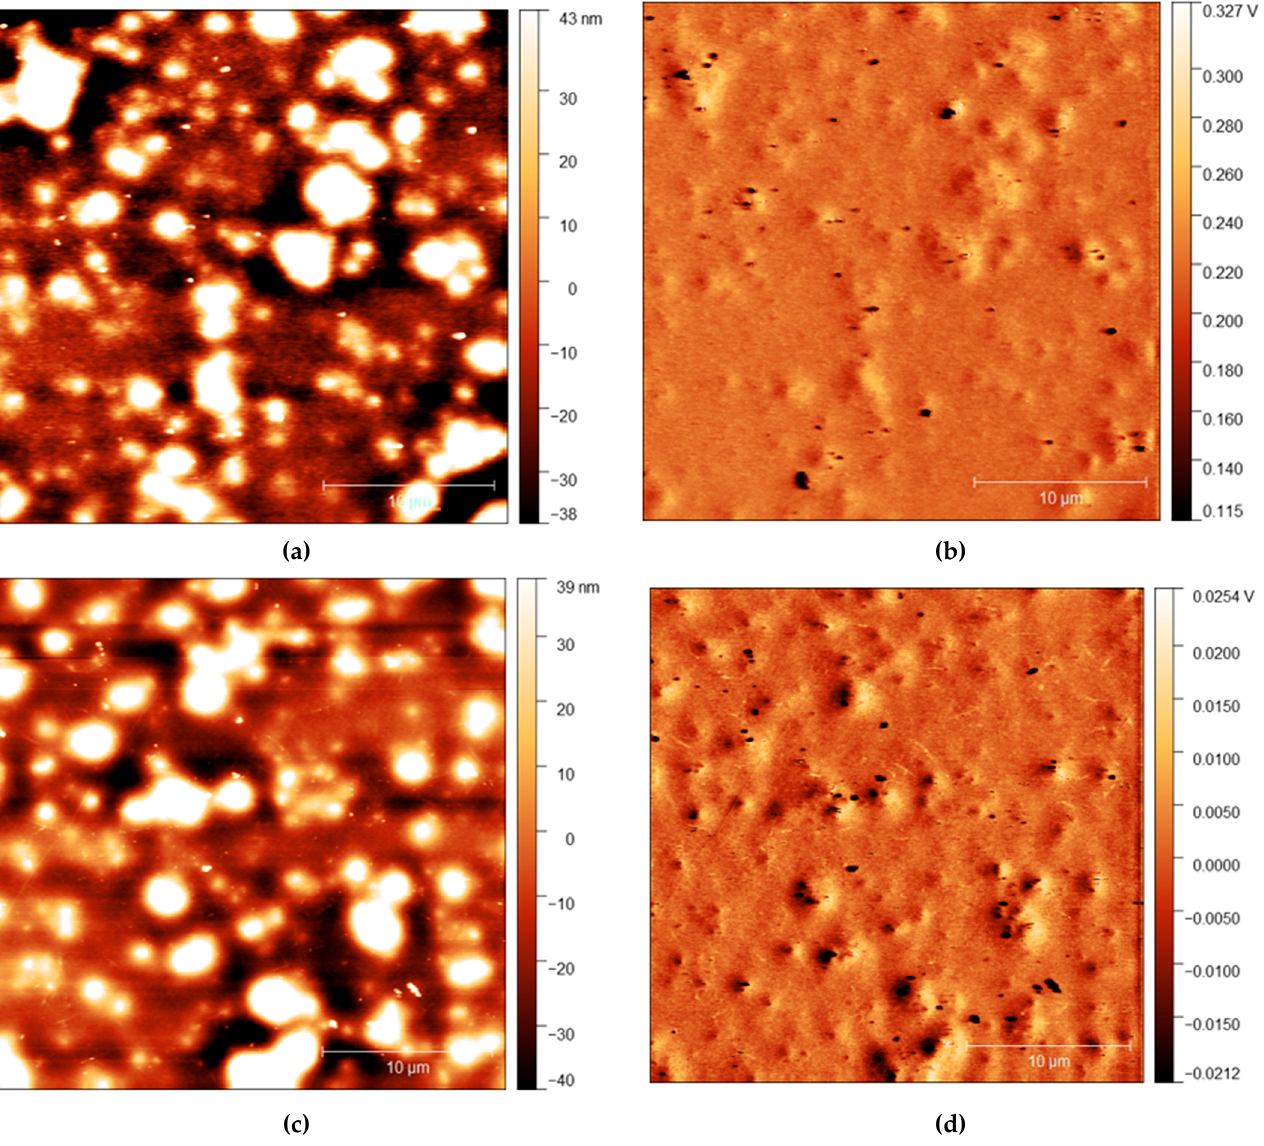
Figure 4. ( a ) AFM height map of cis -PI films with 0% loading of C 12 E 5 and ( b ) Adhesion maps for the same position on the Figure 4. (a) AFM height map of cis -PI films with 0% loading of C 12 E 5 and (b) Adhesion maps for the same position on the same film; ( c ) height map of the same film shown in the top AFM images after 10 s rinse and ( d ) the adhesion same film; (c) height map of the same film shown in the top AFM images after 10s rinse and (d) the adhesion map.